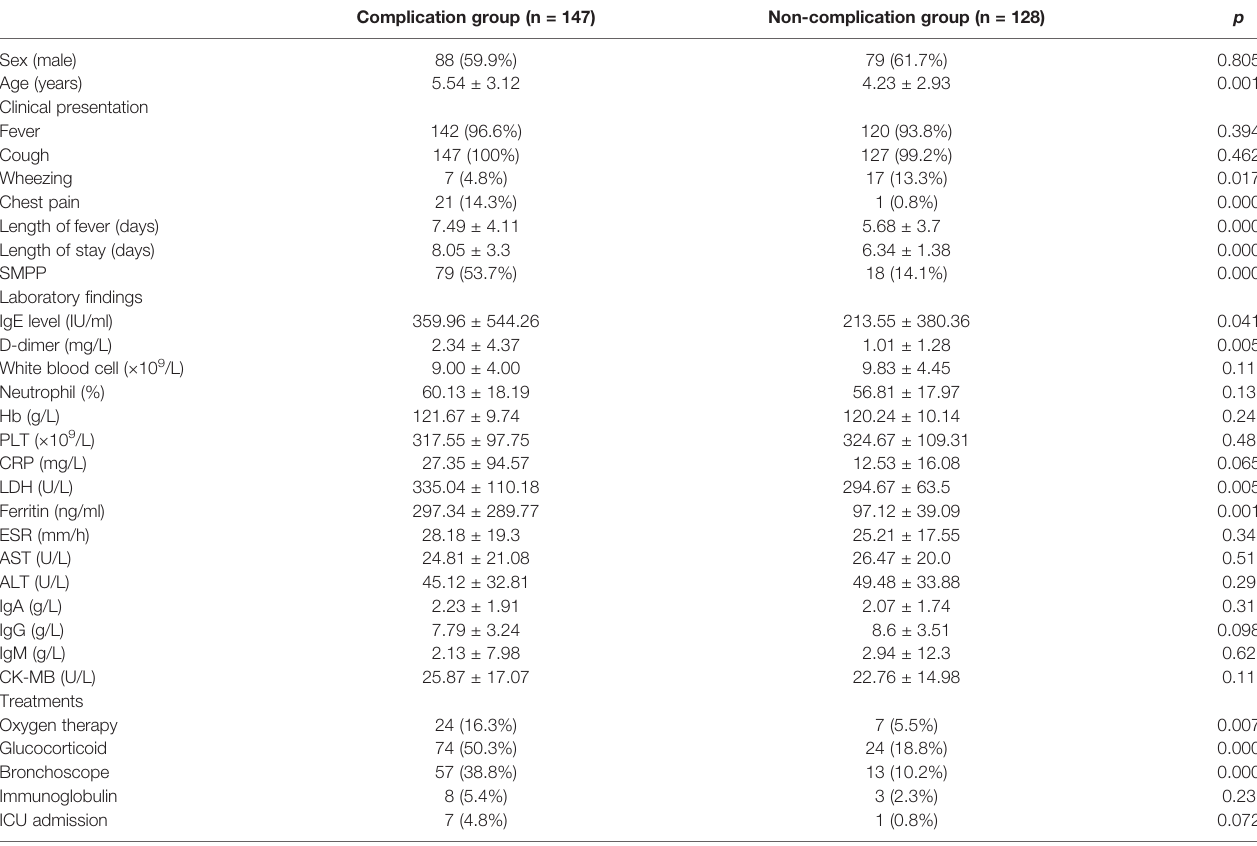
TABLE 3 | The demographics, clinical characteristics, laboratory fi ndings, and treatments of children in the complication group and the non-complication group. Complication group (n =